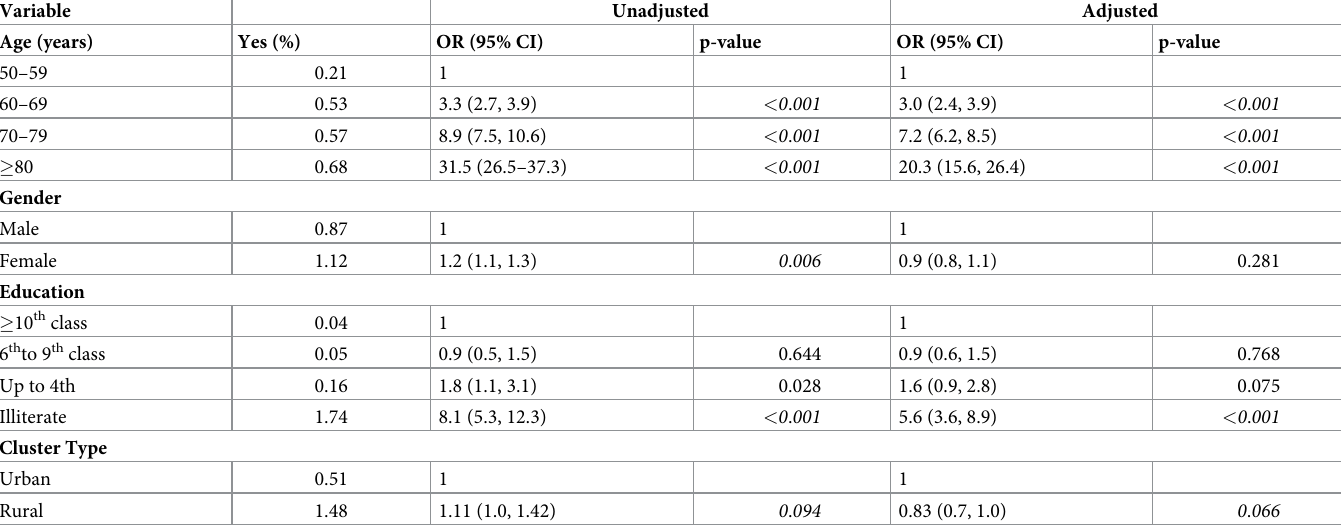
Table 4. Multi-logistic regression analyses showing association of blindness with socio-demographic factors in population aged � 50 years (N = 85135). Variable Unadjusted